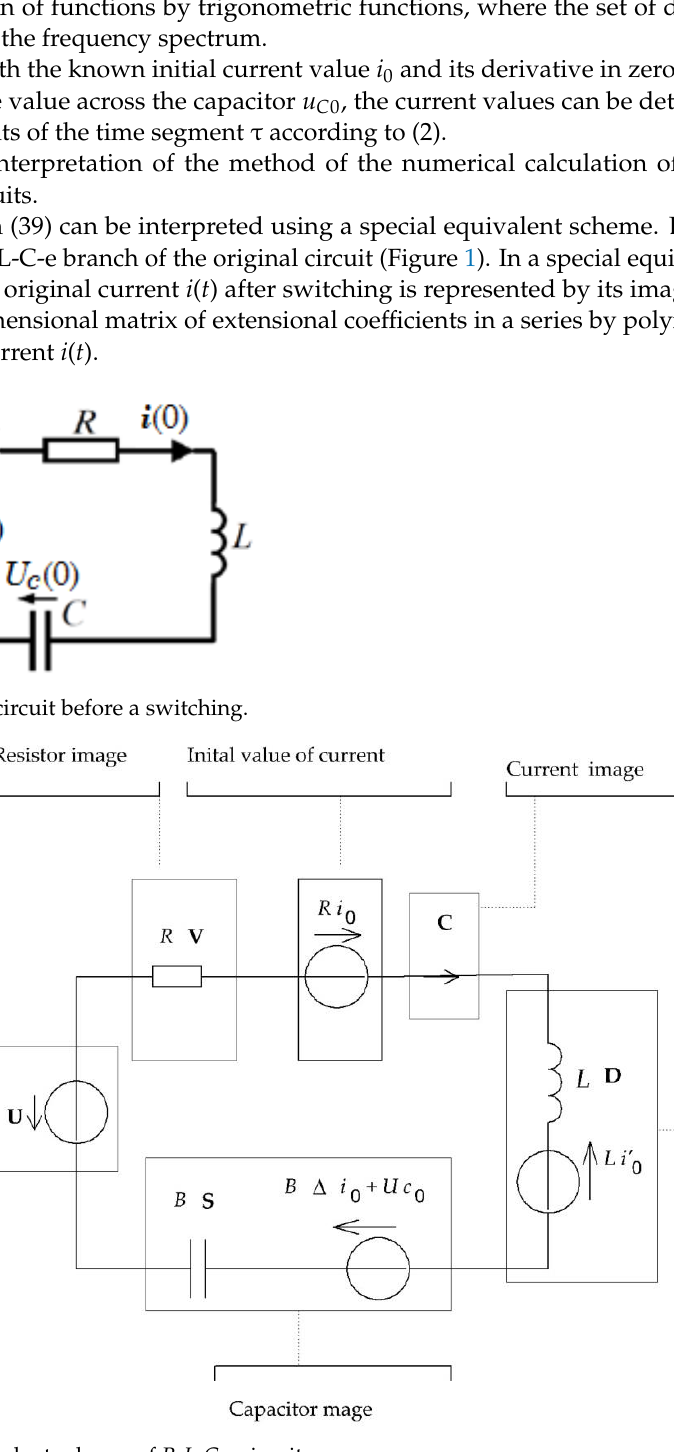
Figure 2. Equivalent scheme of R-L-C-e circuit. The role of total resistance plays 𝐙 = 𝐿𝐃 + 𝑅𝐕 + 𝐵𝐒 .